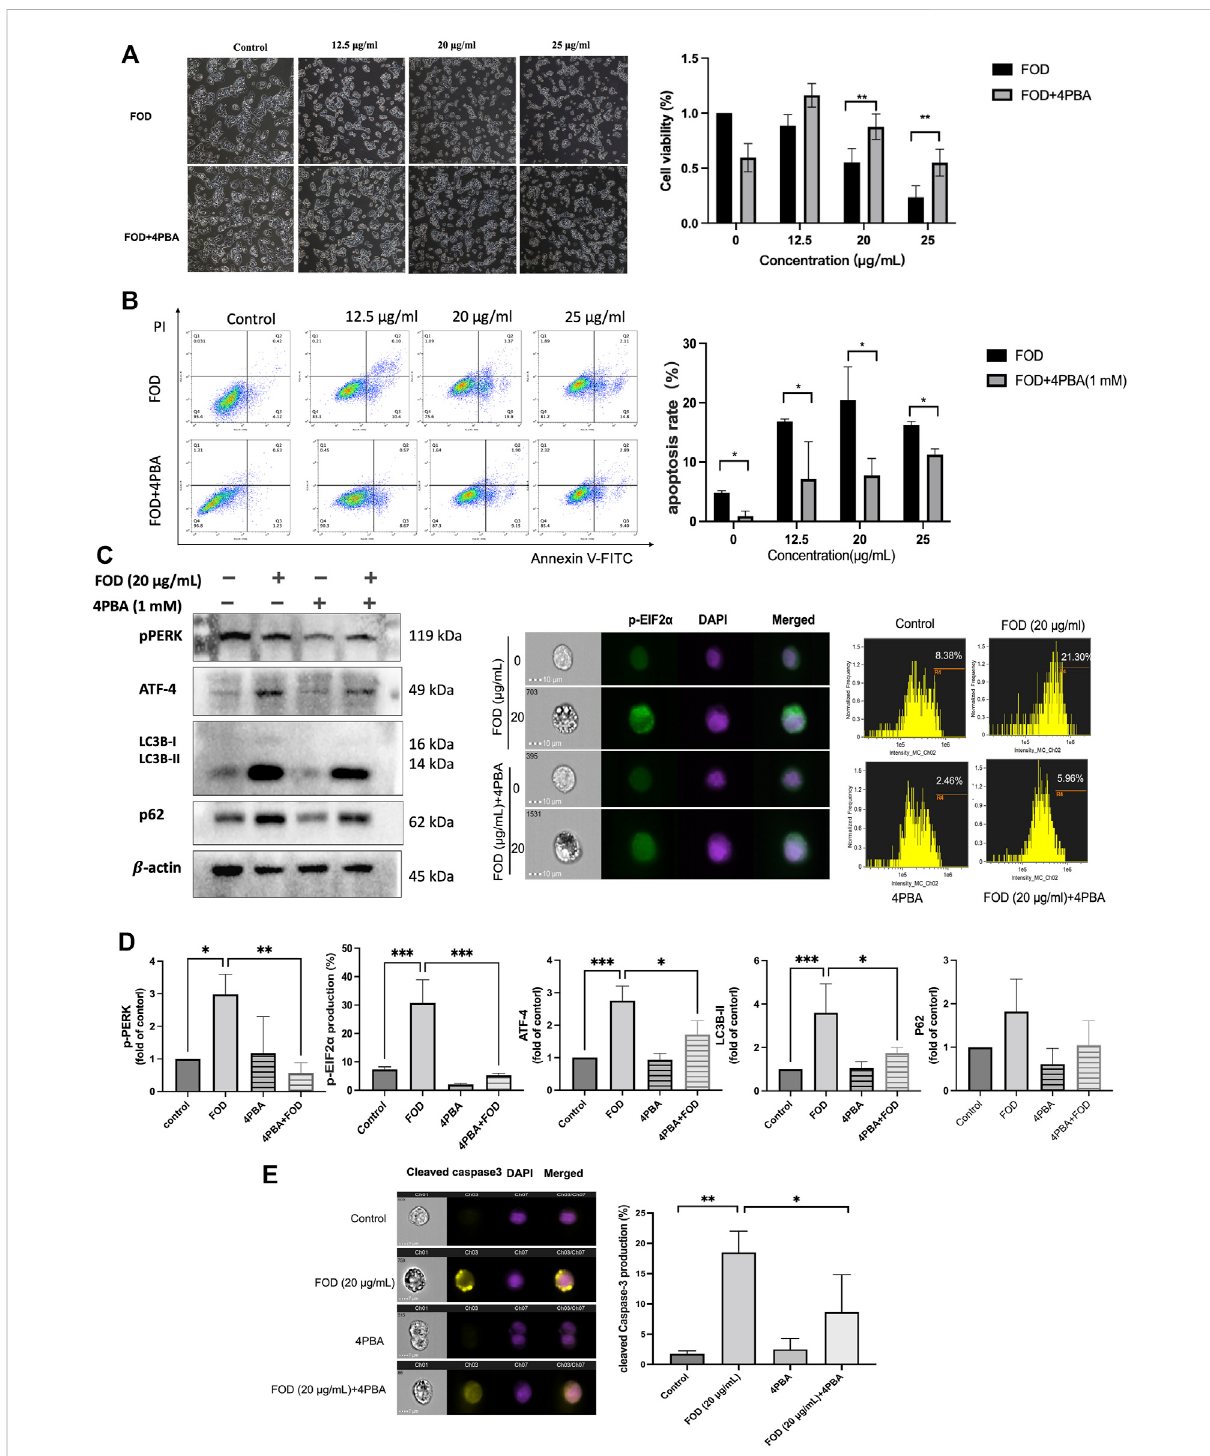
FIGURE 7 (A,B) FODwasincubatedwithHepG2for24 hinthepresenceorabsenceof4PBA (1 mM)pretreatment,andcell viability wasanalyzedbyCCK- 8 assay. The apoptosis rate was detected by fl ow cytometry. (C,E) FOD was incubated with HepG2 for 24 h in the presence or absence of 4PBA (1 mM) pretreatment. The expression levels of p-PERK, ATF4, LC3B-II, P62, p-EIF2 α and Cleaved caspase-3 were detected by Western blotting or fl ow cytometry. (D) Quanti fi cation of expression levels of p-PERK, ATF4, LC3B-II, P62, p-EIF2 α and Cleaved caspase-3. Data were expressedas mean ± standard deviation; * p < 0.05, ** p < 0.01, *** p <